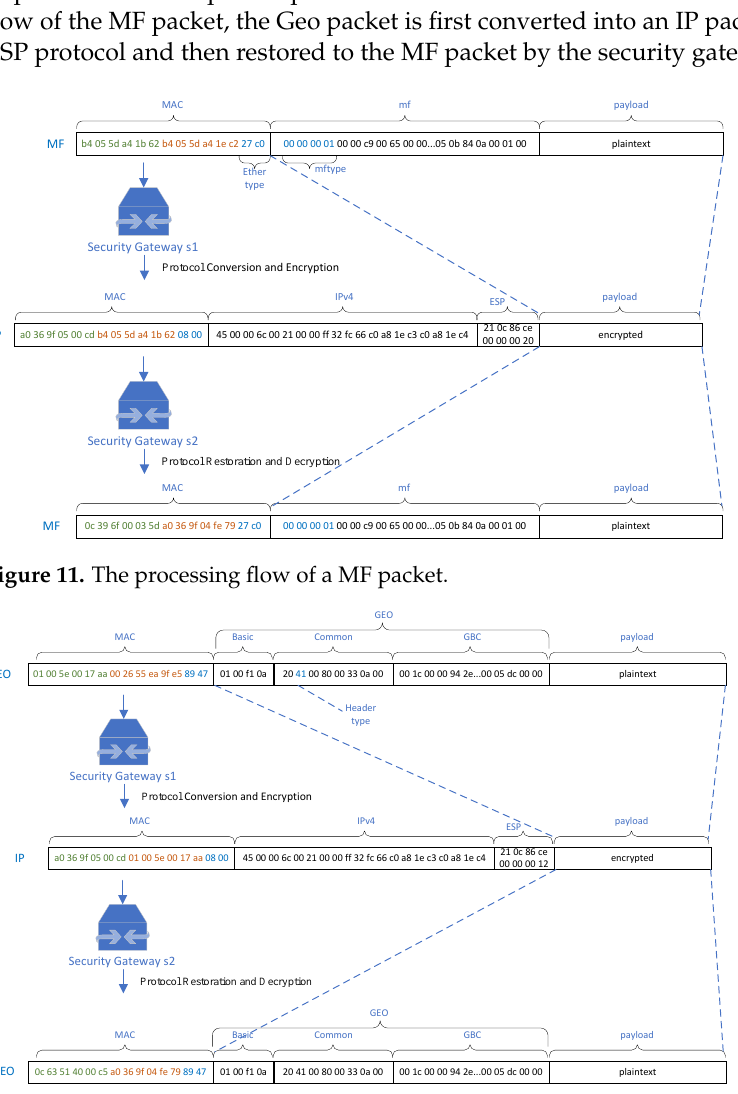
Figure 12. The processing flow of a Geo